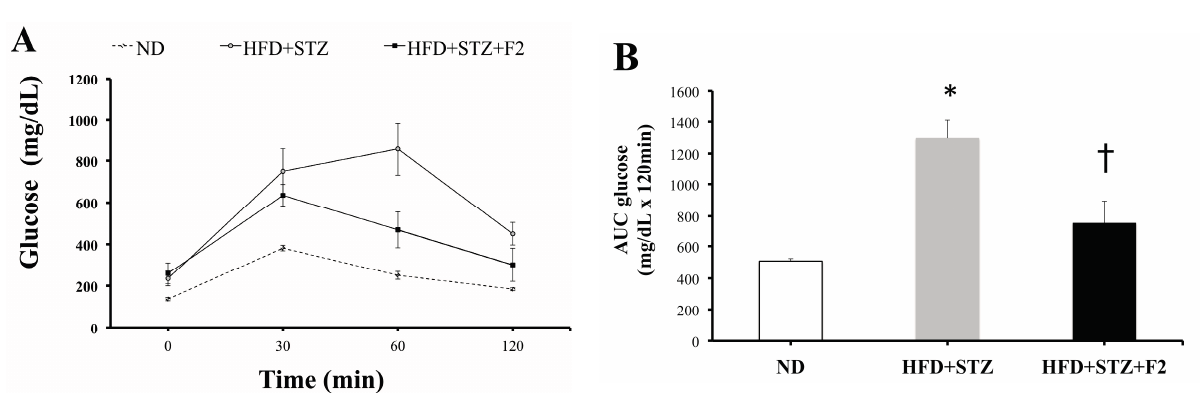
Figure 4. ( A ) IPGTT after 10 IP treatment doses; ( B ) Area under the curve (AUC) values. Times 1, 2, 3 and 4 correspond to 0 min, 30 min, 60 min and 120 min, respectively. ND = normal diet group, HFD+STZ = diabetic control group, and HFD + STZ + ethyl acetate extract F2 = diabetic group given 10 IP doses of ethyl acetate extract F2). * Indicates p < 0.05 for Student’s t -test comparison of ND vs. HFD+STZ. † Indicates p < 0.05 for Student’s t -test comparison of HFD + STZ vs. HFD + STZ + F2. Error bars represent